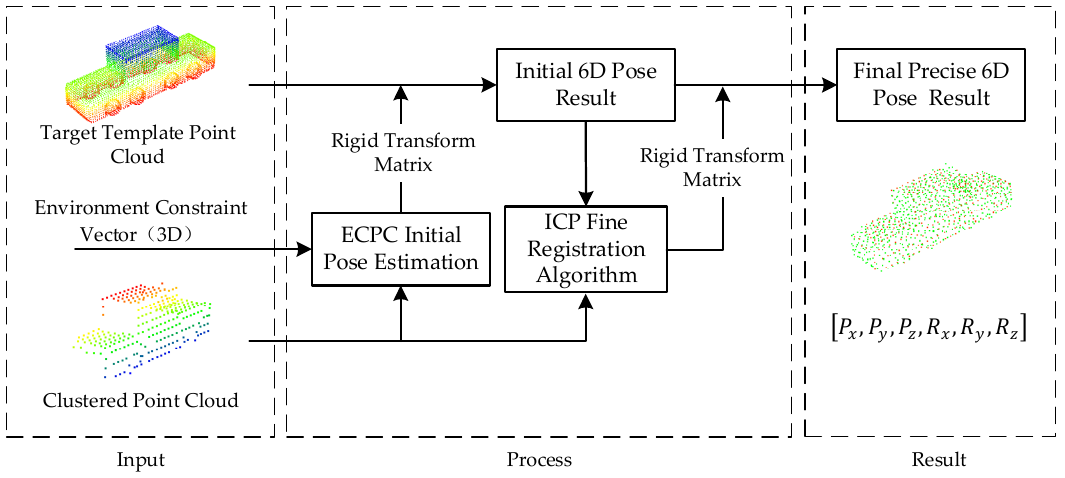
Figure 4. Proposed ECPC-ICP registration method.